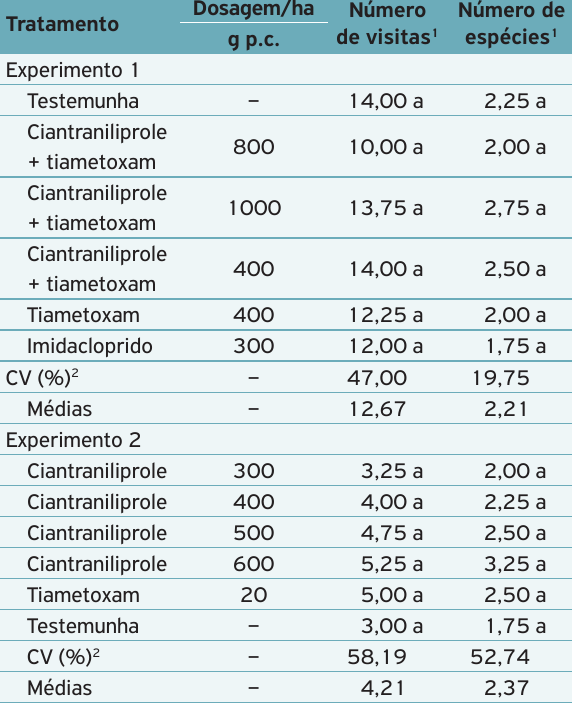
Tabela 4. Número médio de visitas e de espécies de visitantes florais encontradas nos experimentos 1 e 2 na cultura do tomateiro ( Lycopersicon esculentum Mill.), no período de junho a setembro de 2012, Lavras (MG).